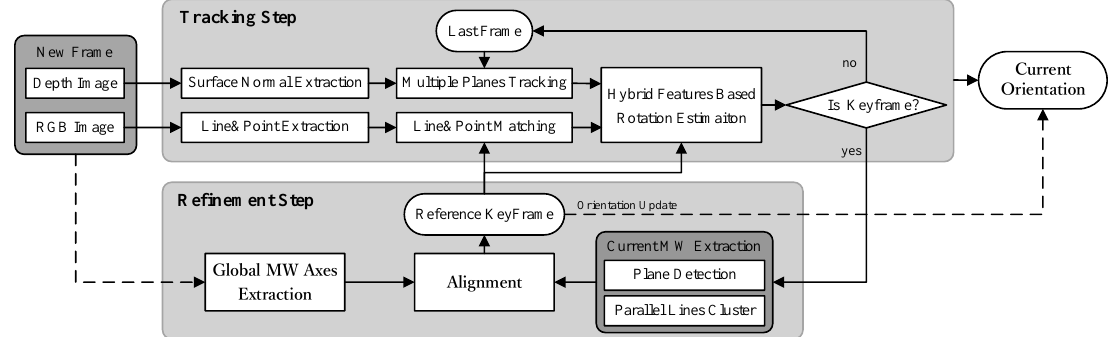
Figure 3. Overview of our visual compass. We estimate camera rotation by tracking the plane, line, and point features. We refine the keyframe orientation by aligning the current Manhattan World (MW) axes with the global MW axes. Global MW axes is extracted from the first captured RGB-D